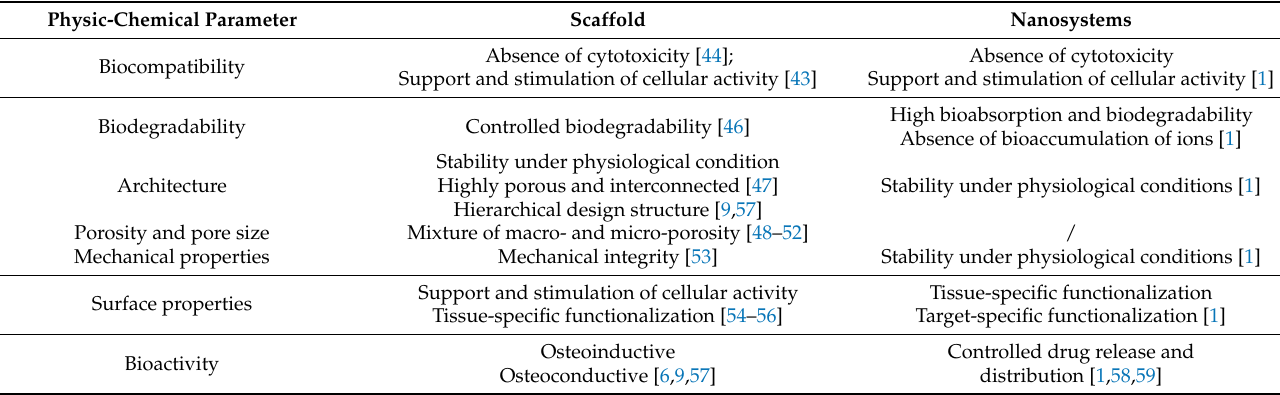
Table 1. Influence of physical chemical properties of hybrid materials on in vitro/in vivo behavior. Physic-Chemical